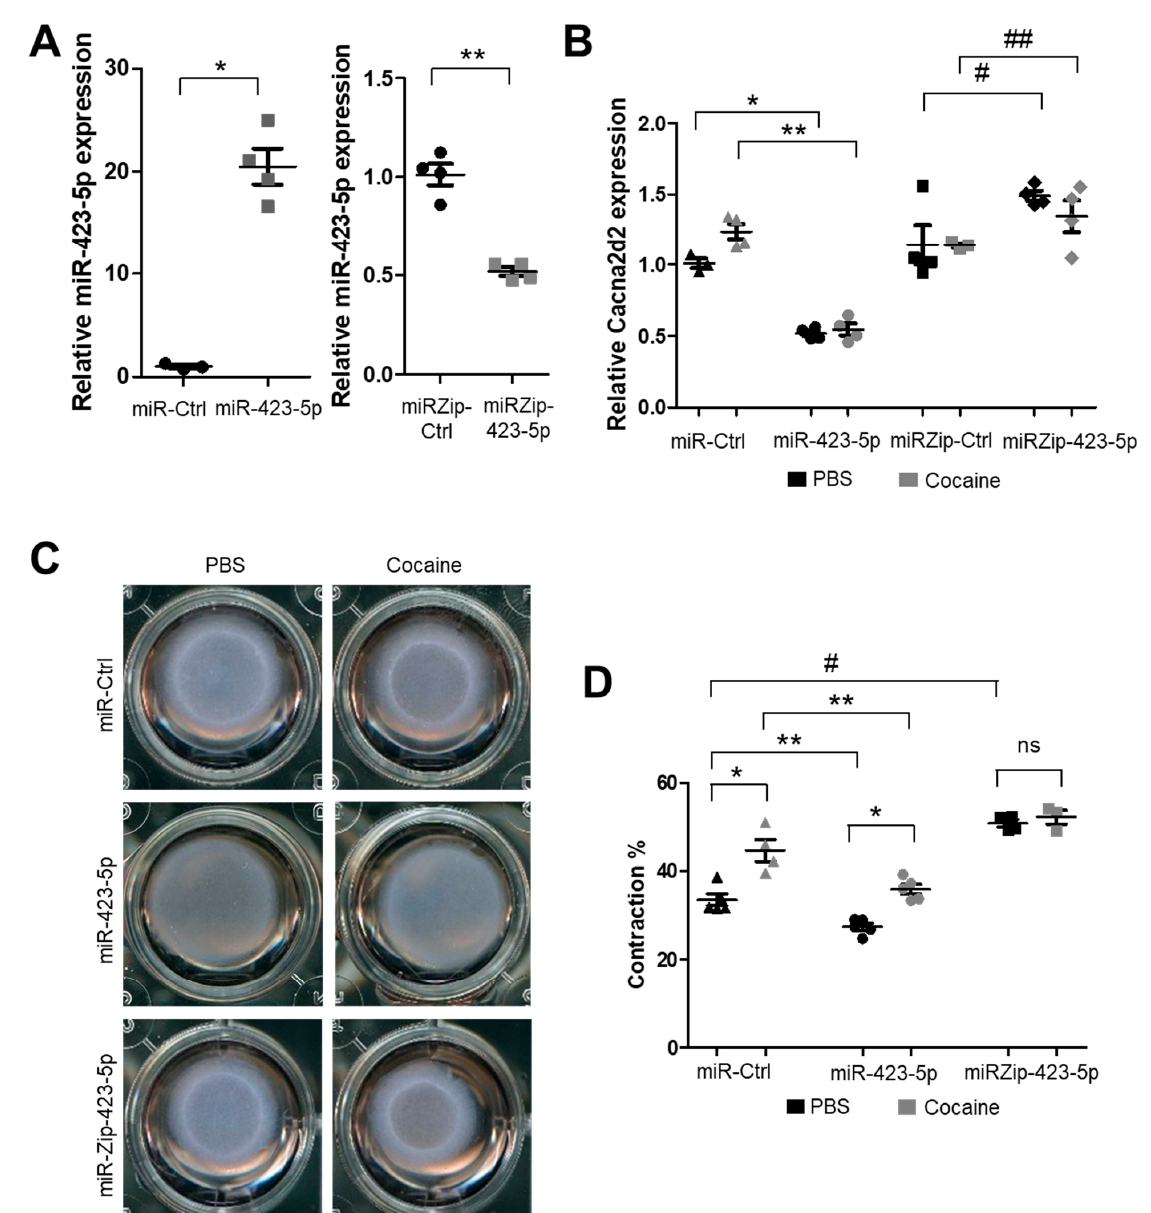
Figure 4. The miR-423-5p-Cacna2d2 axis mediates cocaine-induced SMC contraction. SMCs were transduced with lentiviral vectors encoding control miRNA (miR-Ctr), miR-423-5p, Control